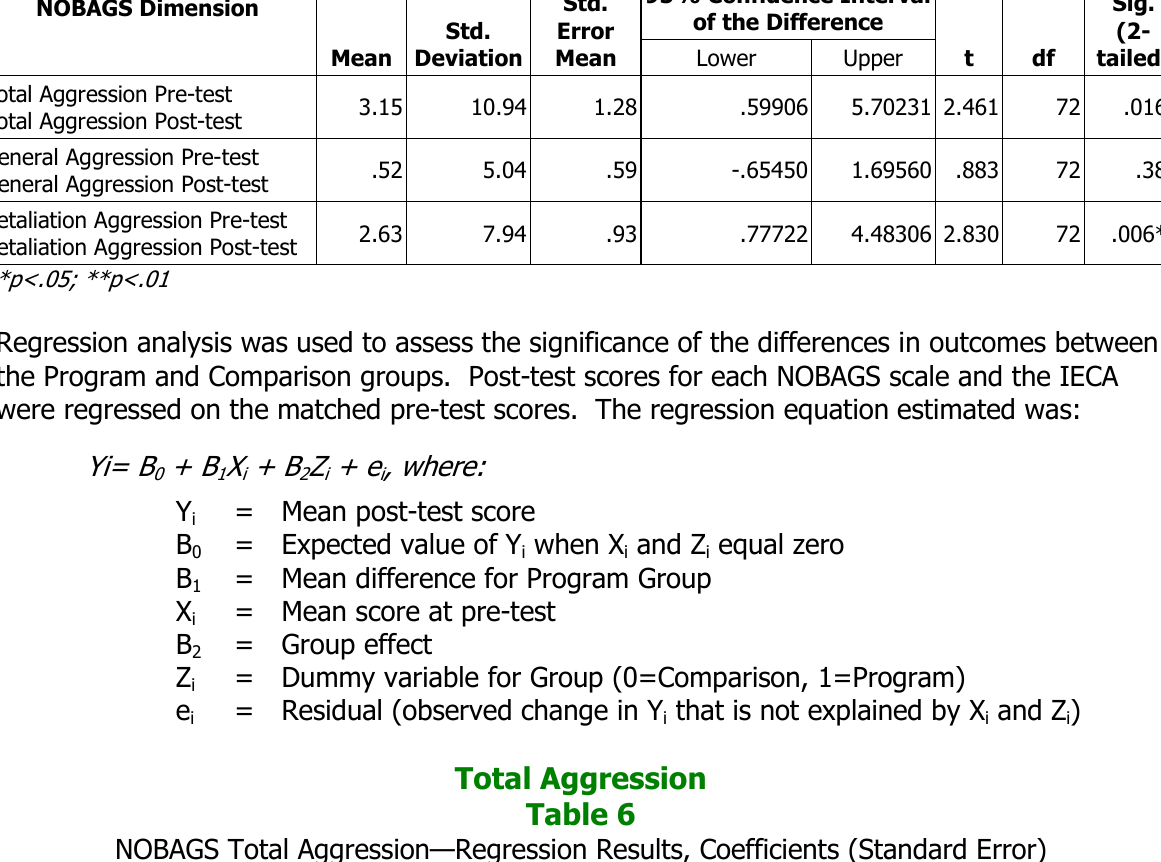
NOBAGS Dimension